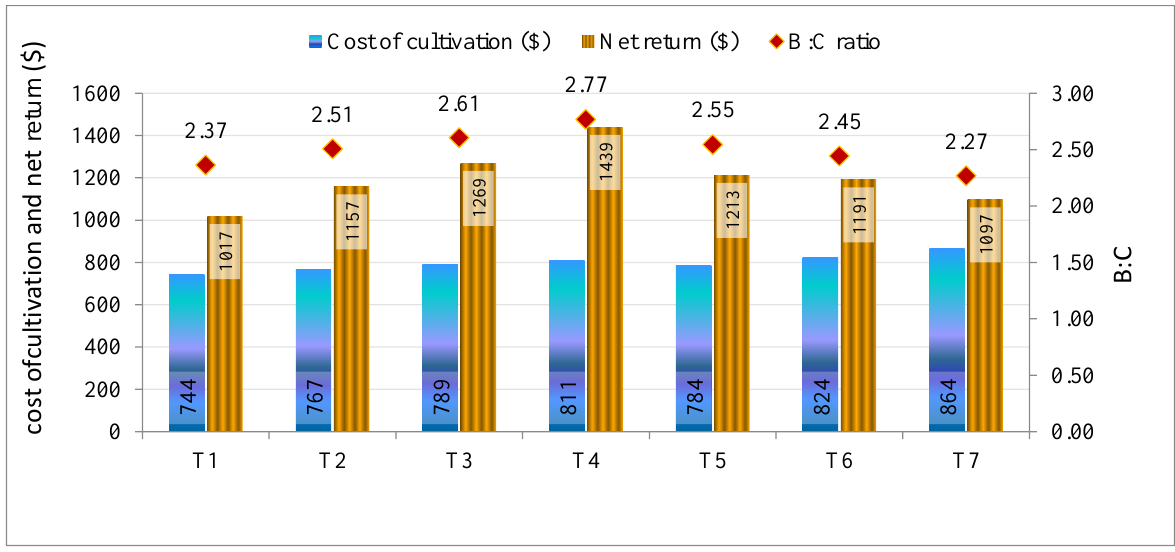
Figure 2. Impact of foliar application of FeSO 4 .7H 2 Oon cost of cultivation, net return, and B:C.